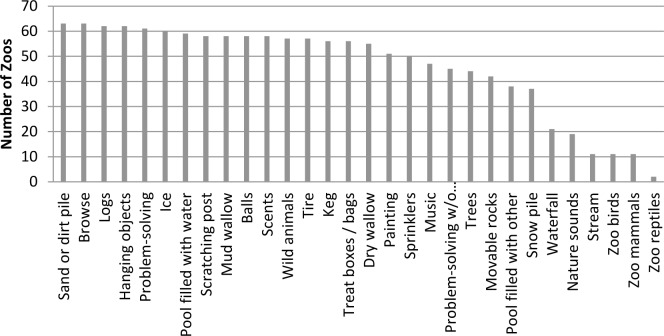
The number of zoos that provided each of the 30 enrichment types.